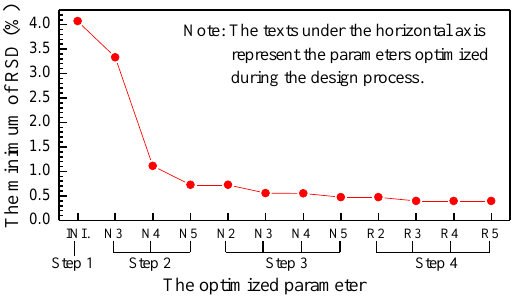
Figure 4. The minimum, δ min , of RSD of effective irradiance density during each sub-step of optimal design.